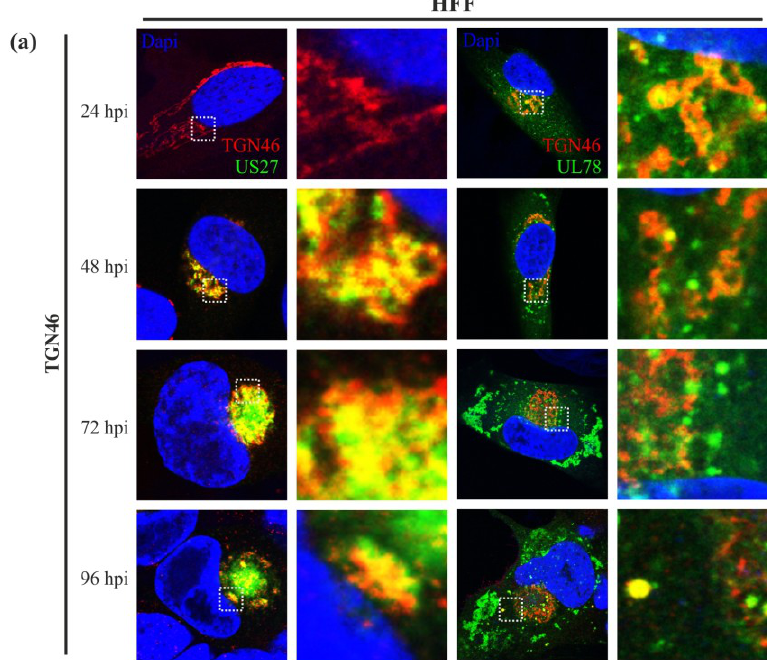
Figure 4. Colocalization of US27-EYFP and UL78-EYFP with TGN46 and calreticulin in infected HFFs. HFFs were infected with recombinant TB40/E viruses (MOI: 0.5) expressing fusion proteins of pUS27 (left panel) or pUL78 (right panel) with EYFP and fixed at different time points during HCMV infection (24–96 hpi). Cells were stained with primary antibody ( a ) pAb-TGN46, diluted 1:300, or ( b ) pAb-Calreticulin (PA3-900), diluted 1:100, and the respective secondary anti-sheep antibody or anti-rabbit antibody coupled to Alexa-555 (1:400). Cell nuclei were stained with